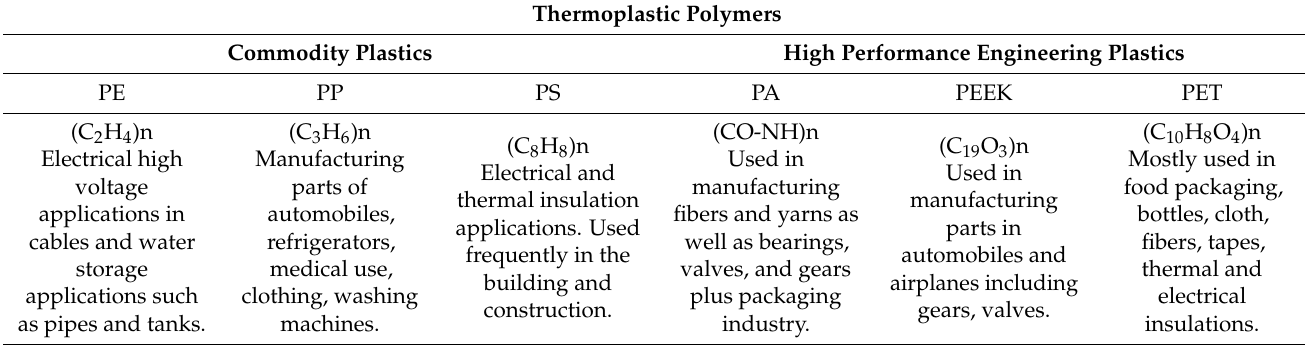
Table 1. Types of thermoplastics include commodity and high-performance engineering plastics. Thermoplastic